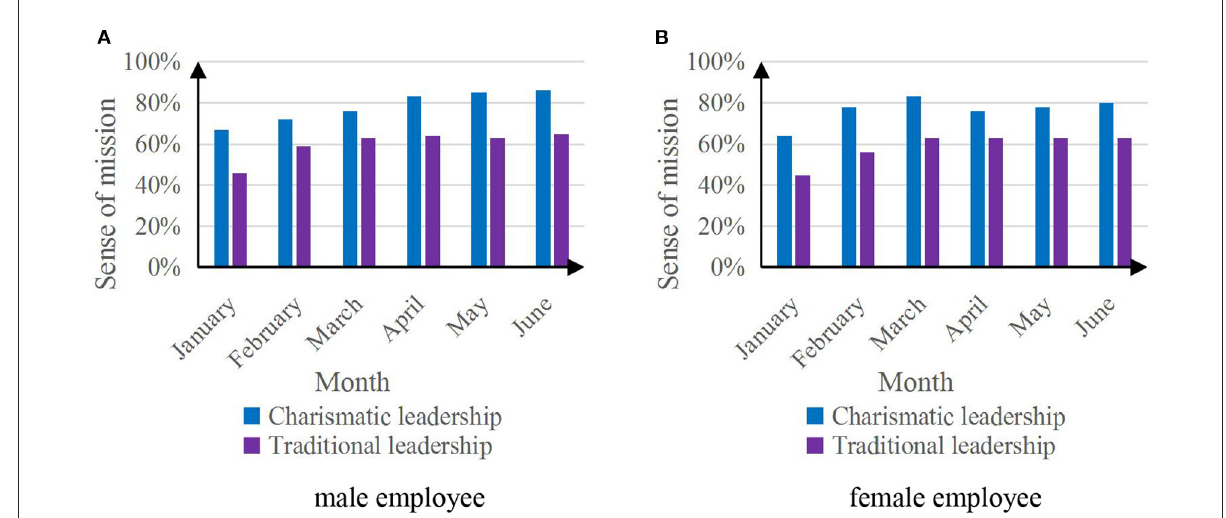
FIGURE8 Sense of mission map of employees to achieve organizational goals. (A) Male employee. (B) Female employee.